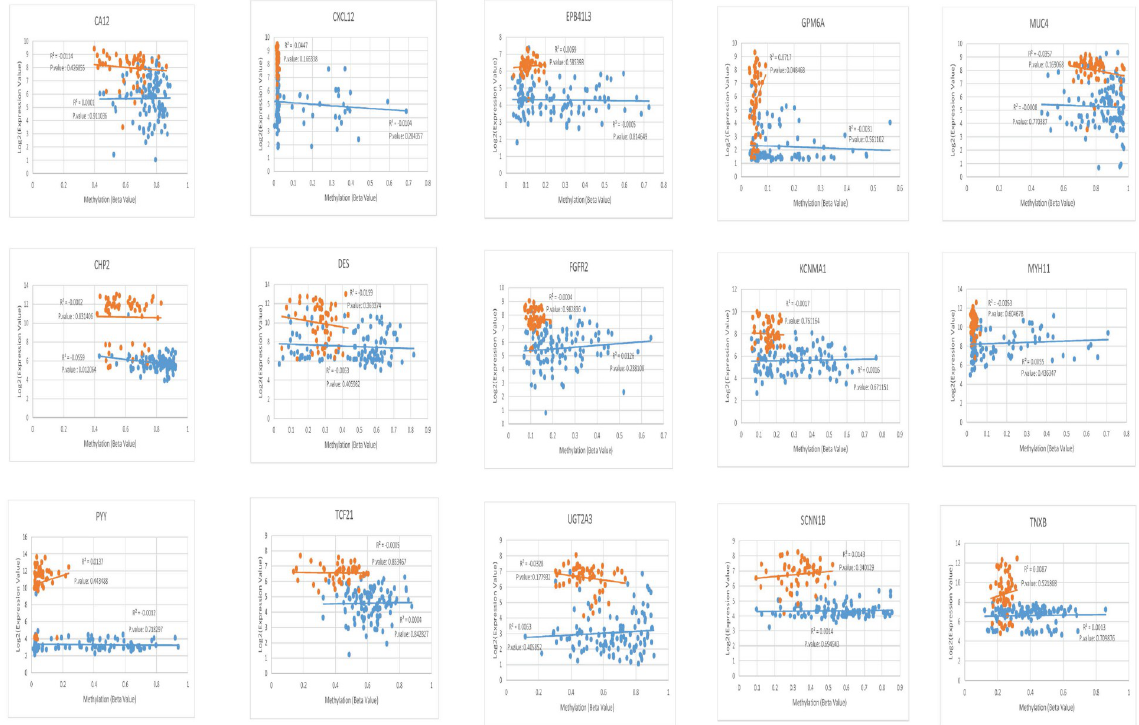
Fig 11. Correlation plots as for under-expressed/hyper-methylated validated Differentially Expressed Genes-Differentially Methylated Genes (vDEGs-DMGs).